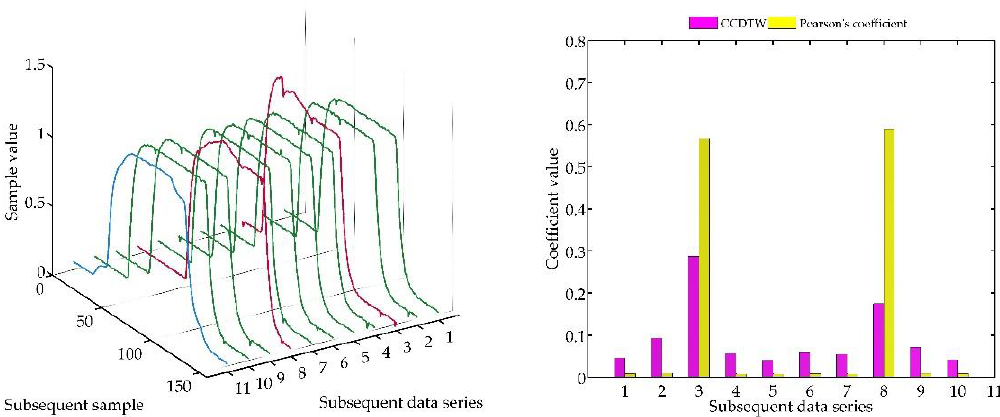
Figure 28. Simulation results based on measurement data for artificially disturbed charts № 3 and № 8 for r ampl = 100.